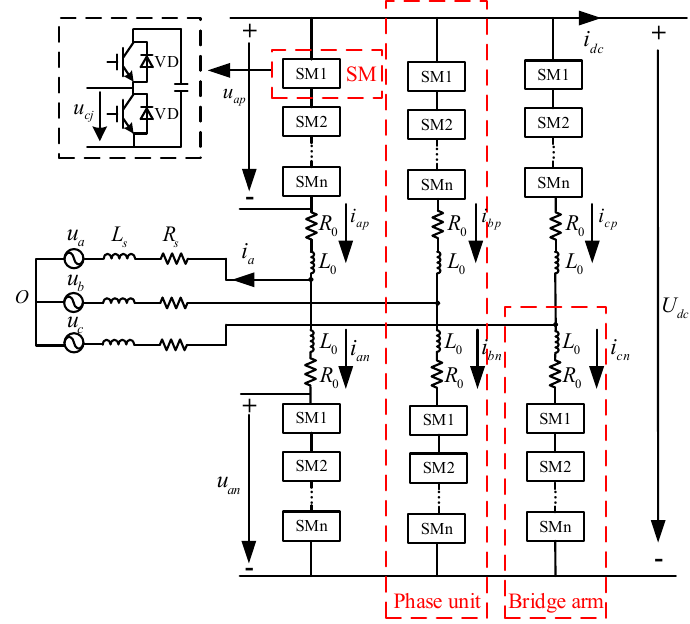
Figure 2. The MMC three-phase topology and sub-module structure.